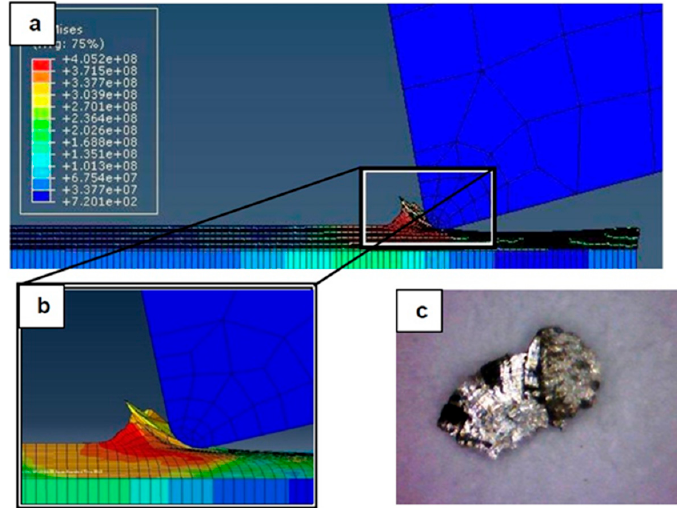
Figure 7. Machining Stainless Steel 316L at feed rate 0.01 mm/rev: ( a ) and ( b ) chip formation, and ( c ) produced chip.